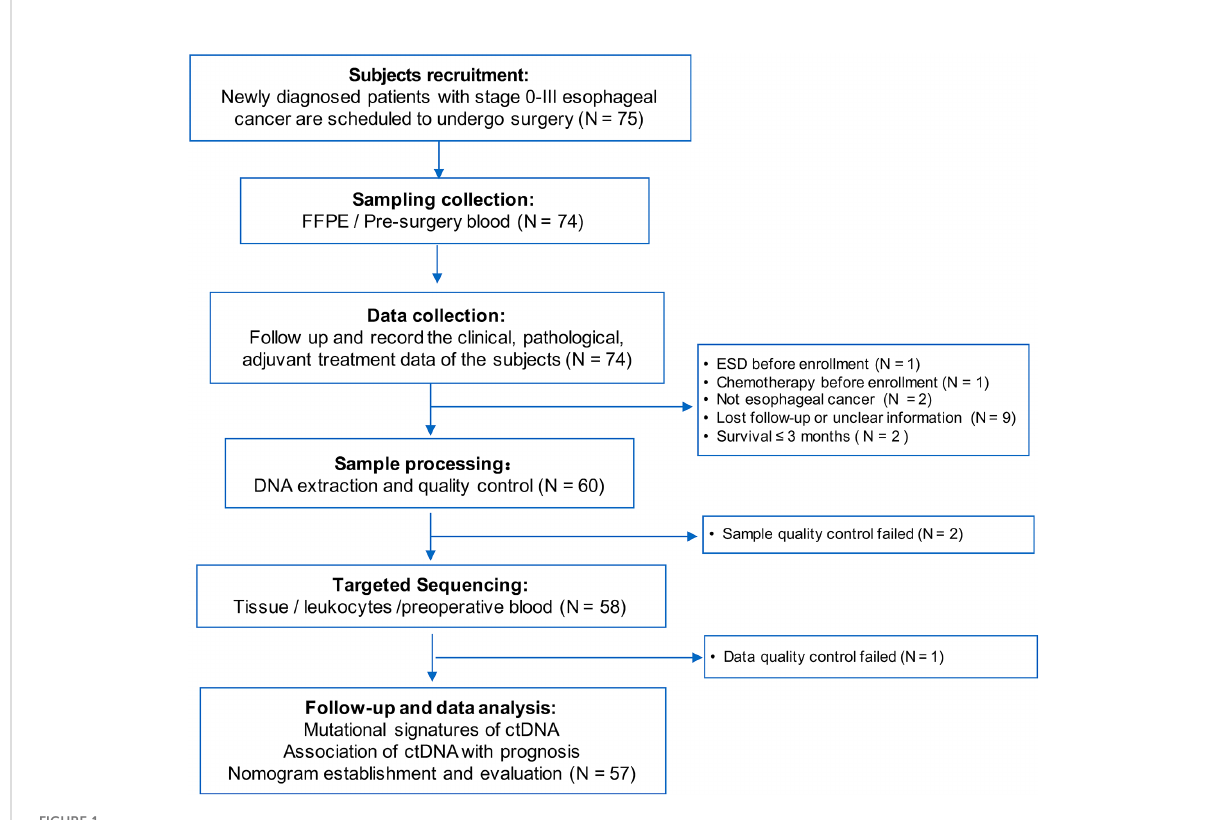
FIGURE 1 Patient selection fl ow of the esophageal squamous cell carcinoma